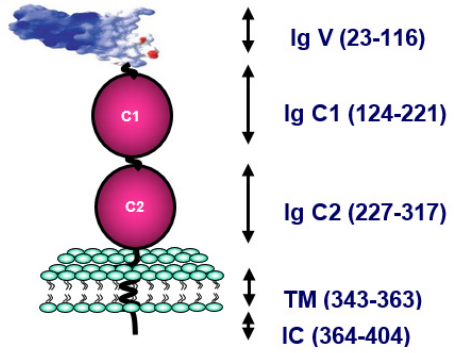
Figure 4. Molecular structure of the Receptor for Advanced Glycation End products (RAGE). Struc- ture of full-length RAGE, including three Ig-like domains: the variable (Ig V) domain, two constants (Ig C1 and Ig C2) in the extracellular part, a single transmembrane domain (TM), and one short cytosolic tail (IC).